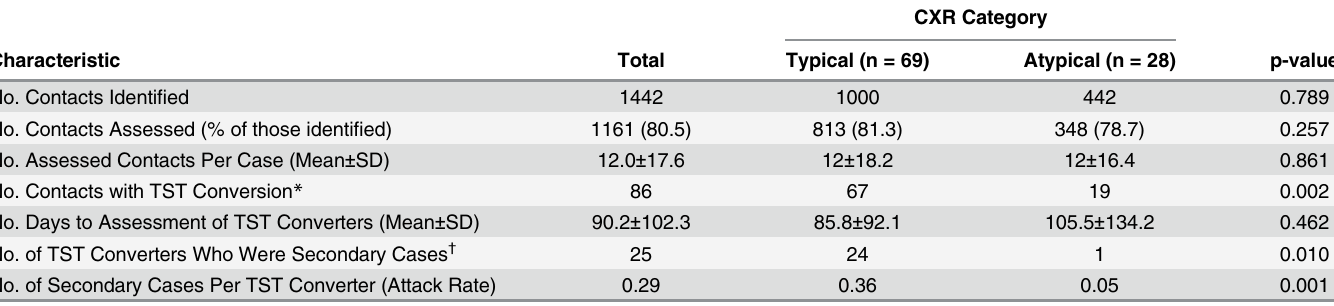
Table 4. Transmission events among close contacts of smear-positive PTB Cases according to chest radiograph category.